Question: What kind of plot is shown here?
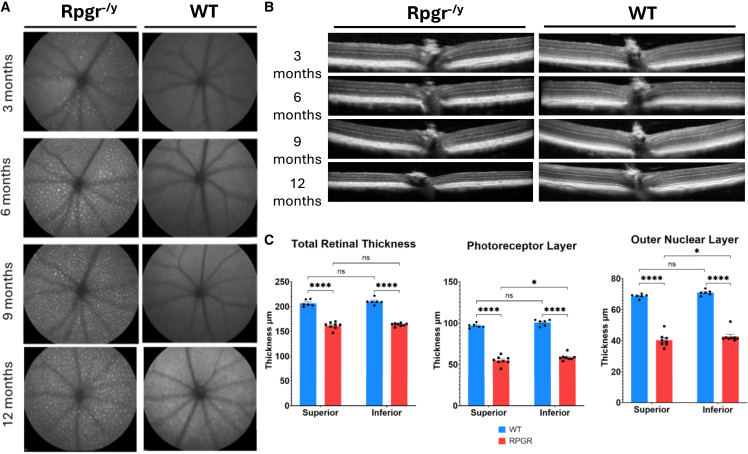
Answer: bar